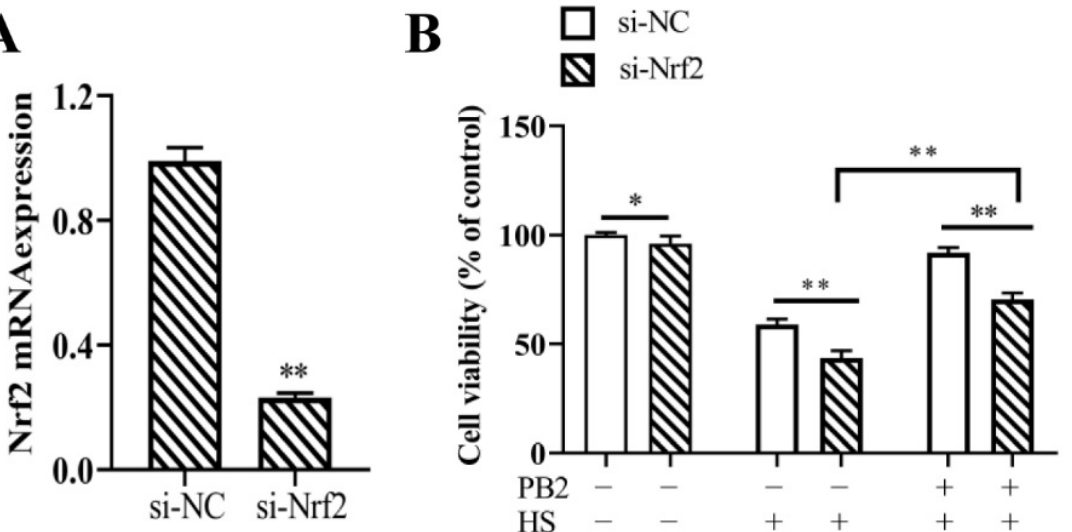
Figure 6. Efficiency of Nrf2 knockdown and its effect on MAC-T cell viability. ( A ) MAC-T cells were transfected with si-Nrf2 or si-NC for 12 h. After 48 h of transfection, cells were collected to detect Nrf2 mRNA expression level. n = 3. ( B ) Additionally, MAC-T cells were transfected with si-Nrf2 or si-NC for 12 h, then incubated with/without 25 µ M PB2 for 24 h, followed by HS treatment for 3 h and recovery for 6 h. Then, cell viability level was determined. n = 6. * p < 0.05, ** p < 0.01.